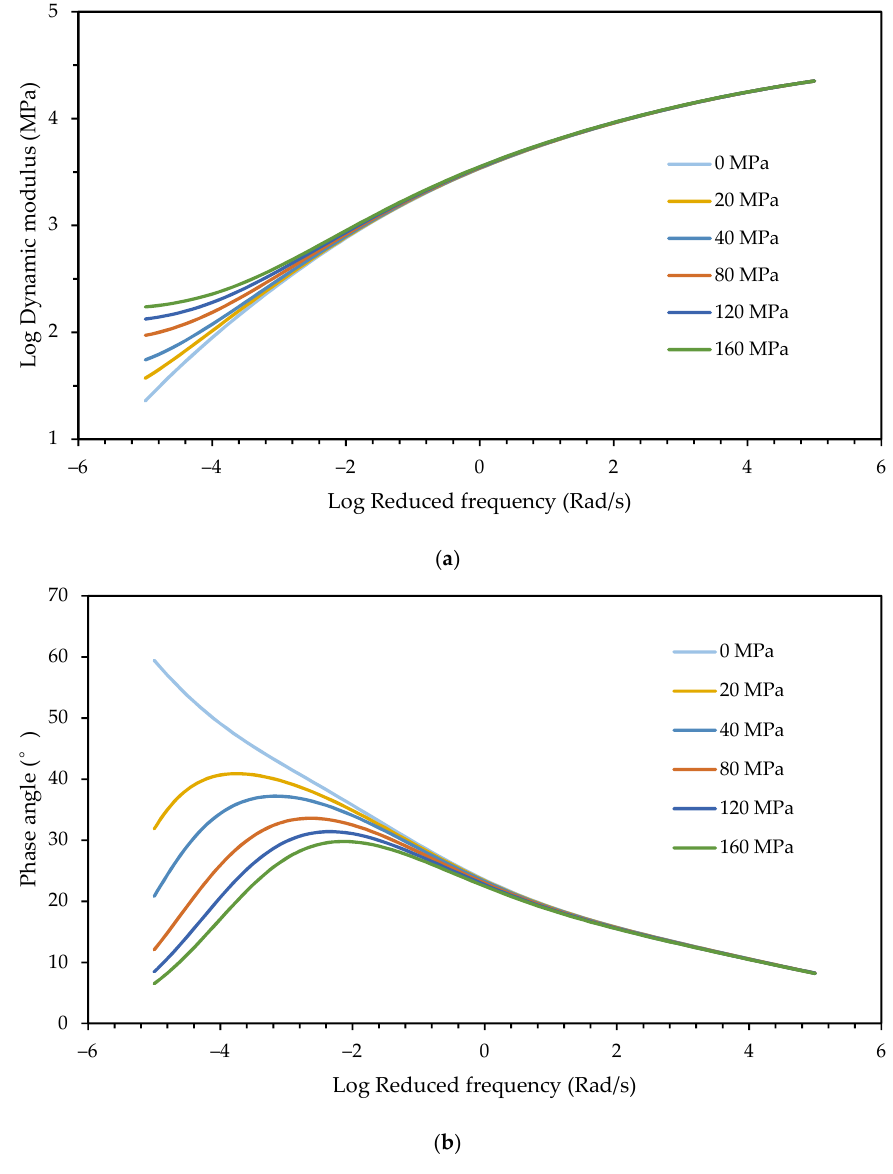
Figure 11. Effect of the equilibrium modulus: ( a ) Dynamic modulus; and ( b ) phase angle. Figure 11. E ff ect of the equilibrium modulus: ( a ) Dynamic modulus; and ( b ) phase